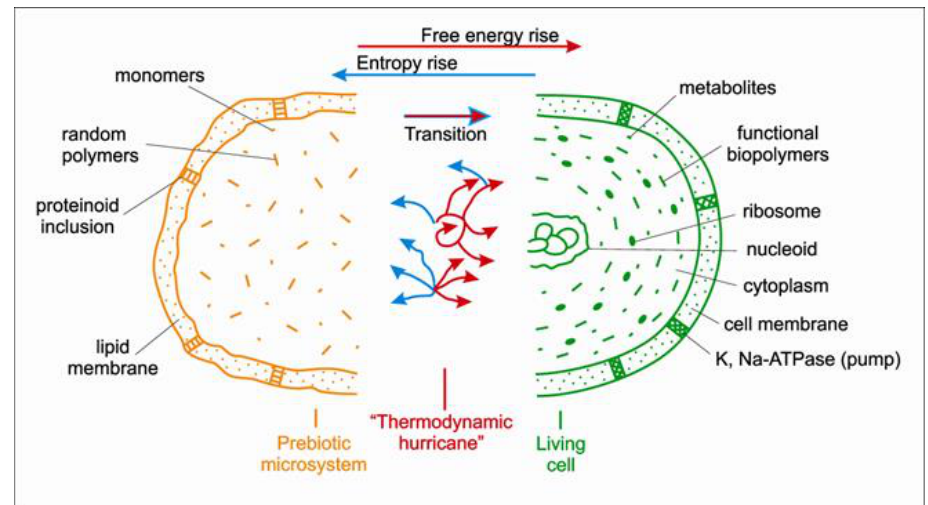
Figure 2. The left hand, orange half comprises the prebiotic microsystem composed of a random mix of monomers and other relevant smaller, simpler molecules, as well as polymers. The central part represents the transition of the prebiotic microsystem into simplest living entity (initial cell), when the processes producing free energy (red arrows) become more efficient than those producing entropy (turquoise arrows); this stage is conditionally termed: “thermodynamic hurricane”. The right-hand, green half shows the emergence of the simplest living entity, namely probiont, whose further evolution led to the formation of the main cellular structures, such as the nucleoid with its circular DNA, ribosomes and cell membrane. (Readers may wish to consult Kompanichenko, 2017, book entitled: “Thermodynamic Inversion: Origin of Living Systems”).